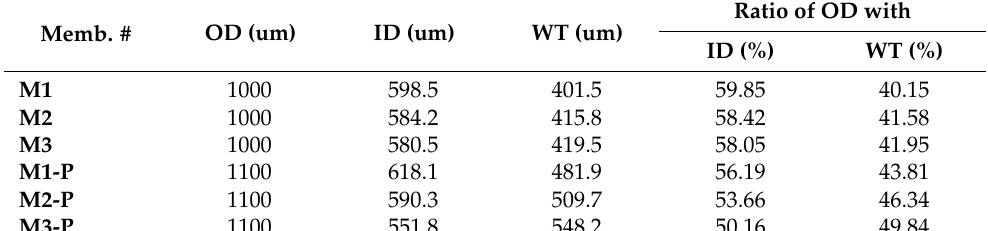
Table 3. The dimension of fabricated and post-treated HFs membranes, measured by FESEM standard software, which included the outer diameter (OD), inner hole diameter (ID), and wall thickness (WT). Memb. #